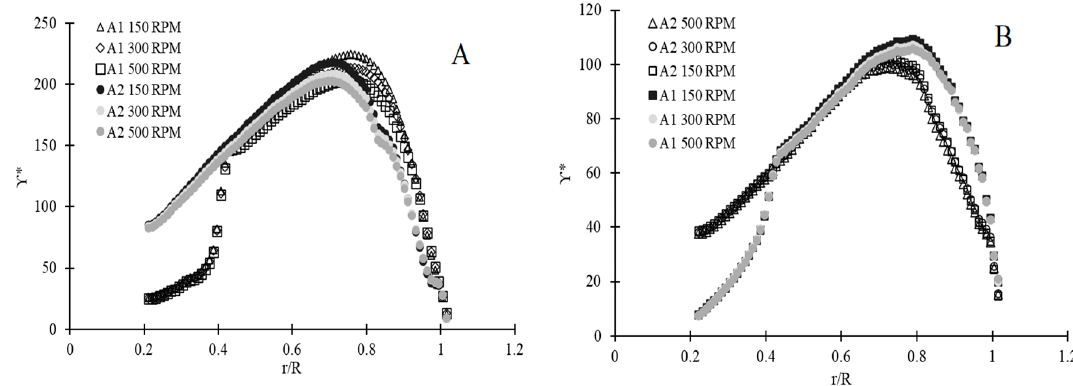
Figure 12. Distribution of dimensionless shear rates ( A )— c a = 1 mm, ( B )— c a = 3 mm.